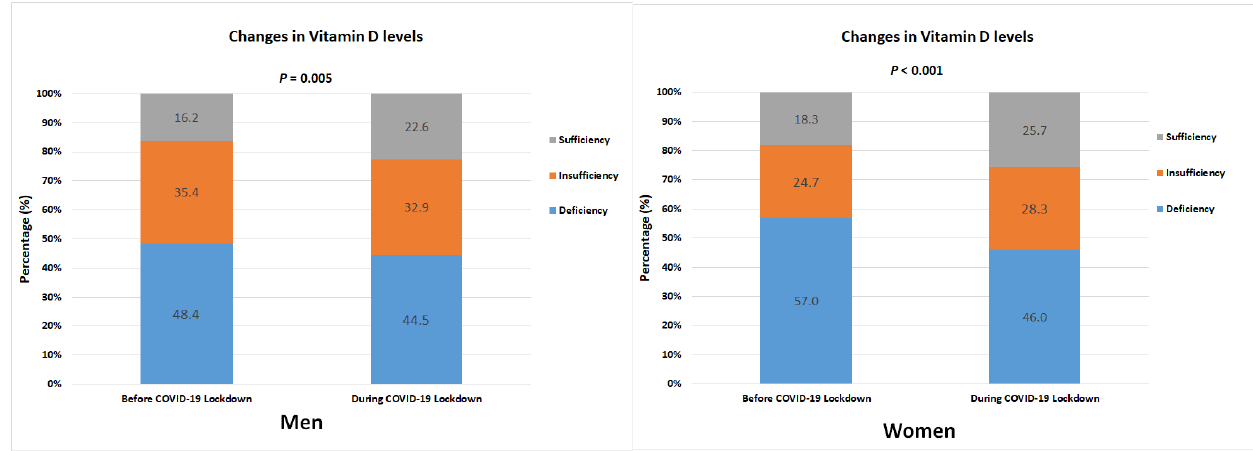
Figure 2. Changes in the prevalence of deficiency (<20 ng/mL), insufficiency (20 – 29.9 ng/mL), and sufficiency ( ≥ 30 ng/mL) of vitamin D by gender after the COVID-19 pandemic. Both before and after the COVID-19 pandemic, those with sufficient vitamin D levels comprised the smallest proportion of the population. In males, 133 (16.2%) were vitamin